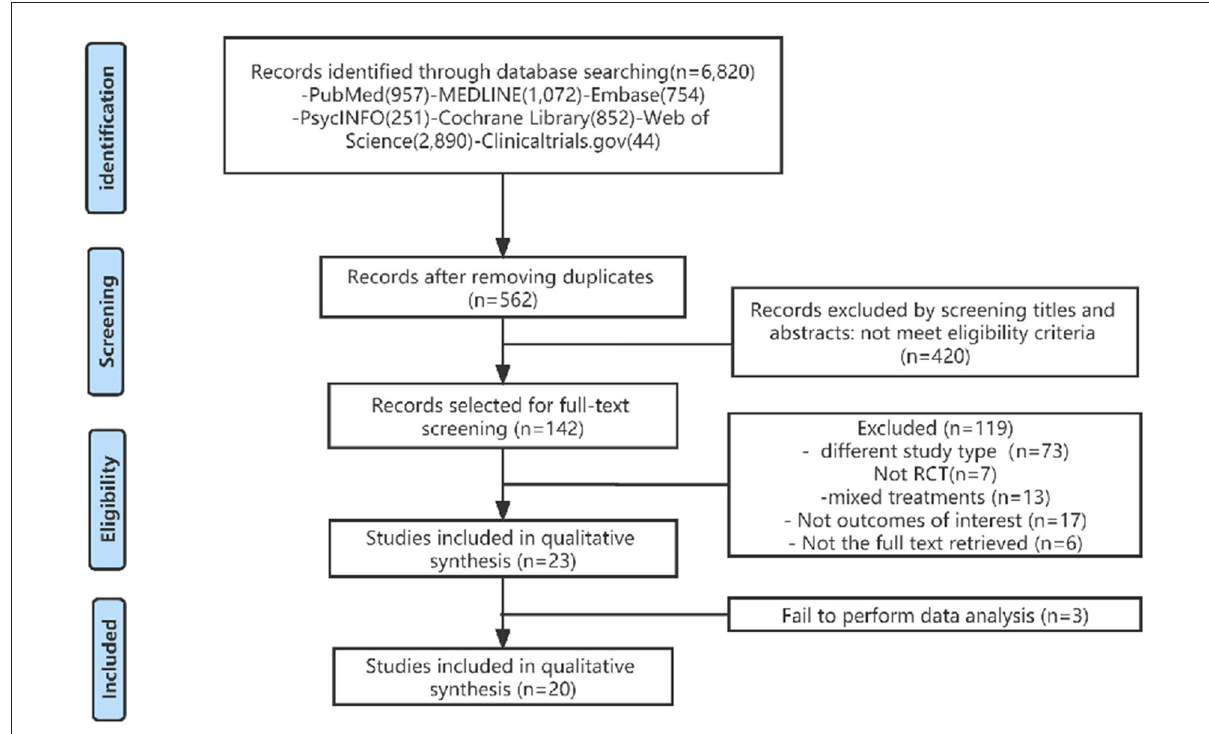
FIGURE1 Flow chart illustrating the different phases of the search and study